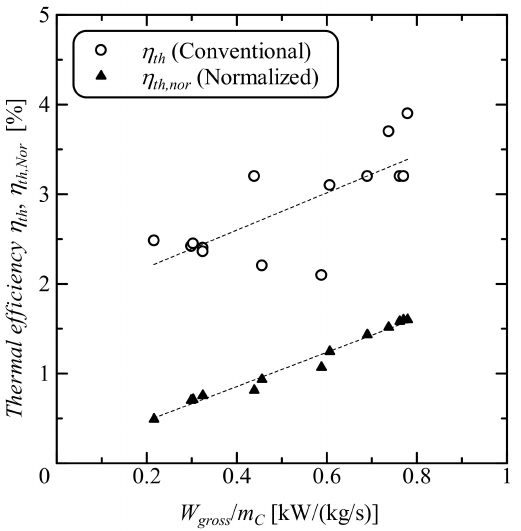
Figure 7. Dependency of conventional and normalized thermal efficiencies and gross power per deep seawater flow rate. The open circles show the thermal conventional efficiency, η th , and the close triangles show the normalized thermal efficiency, η th,Nor .